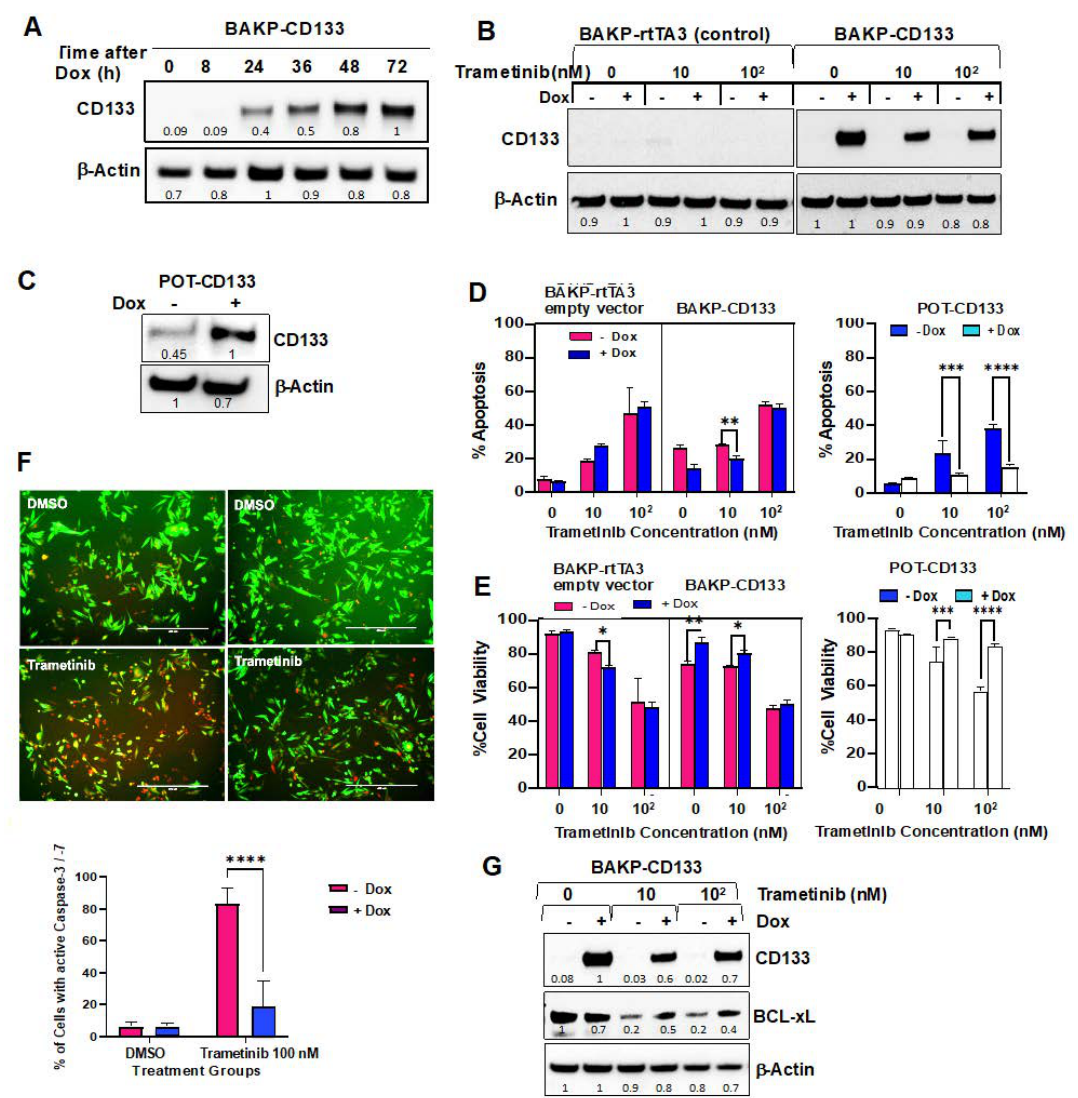
Figure 5. Dox-induced CD133 expression in BAKP ( A , B ) and POT ( C ) cells, as verified by immunoblot analysis, suppress caspase-3 mediated apoptotic cell death ( D , F ) and increases cell viability ( E ) after trametinib treatment (dose-response experiments). ( A ) Cells were incubated with Dox for the indicated times and subjected to immunoblot analysis with antibodies to CD133 and β -actin for normalization. ( B ) Immunoblot analyses with anti-CD133 of BAKP-CD133 and vector control BAKP- rtTA3 cells treated with increasing trametinib doses +/ − Dox, as well as ( C ) POT-CD133 cells incubated +/ − Dox for 72 h. ( D ) BAKP-CD133, BAKP-rtTA3 empty vector control, and POT-CD133 cells were exposed to increasing doses of trametinib for 72 h, and subjected to Annexin-FITC/PI apoptosis assays; apoptosis (%; D ) and cell viability (%; E ) of cells are shown. ( F ) Fluorescent FLICA Caspase 3/7 activity assays reveal a significant decline in caspase 3 activity in trametinib-treated CD133-expressing BAKP cells (+Dox), compared to uninduced cells ( − Dox); representative merged images of red fluorescent FLICA- and GFP-positive cells (10 × ) (left panel); quantification of FLICA- positive cells (with active caspase-3, right panel). ( G ) Immunoblot analyses with antibodies to CD133, BCL-xL, and β Actin of BAKP-CD133 treated with increasing trametinib doses +/ − Dox. BAKP- CD133 cells were constitutively expressing GFP. Results shown are the means ± SD of three biological replicates of a representative experiment of three independent experiments. *, **, ***, **** represent p < 0.05, p < 0.01, p < 0.001, and p < 0.0001, respectively. Densitometric analysis comparing intensities of protein bands relative to bands with the highest intensity is shown in